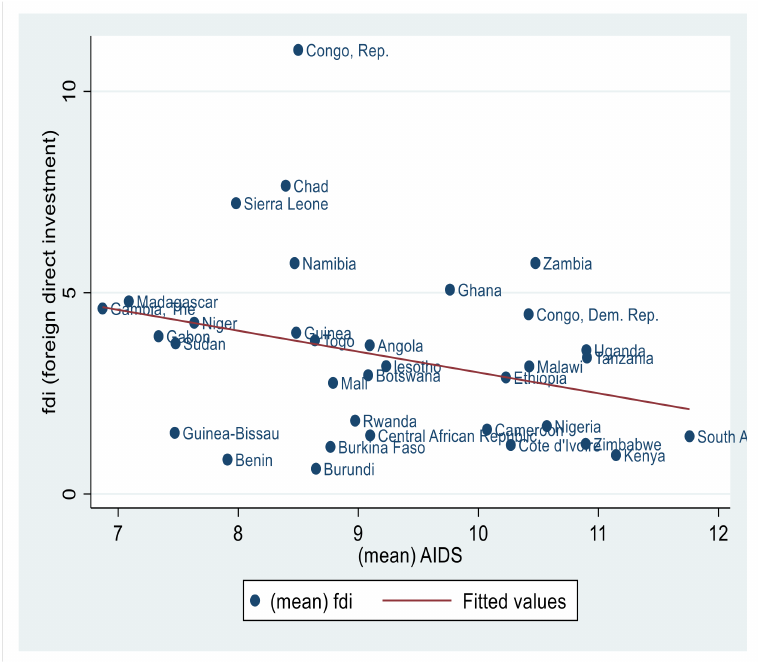
Figure 9. AIDS and